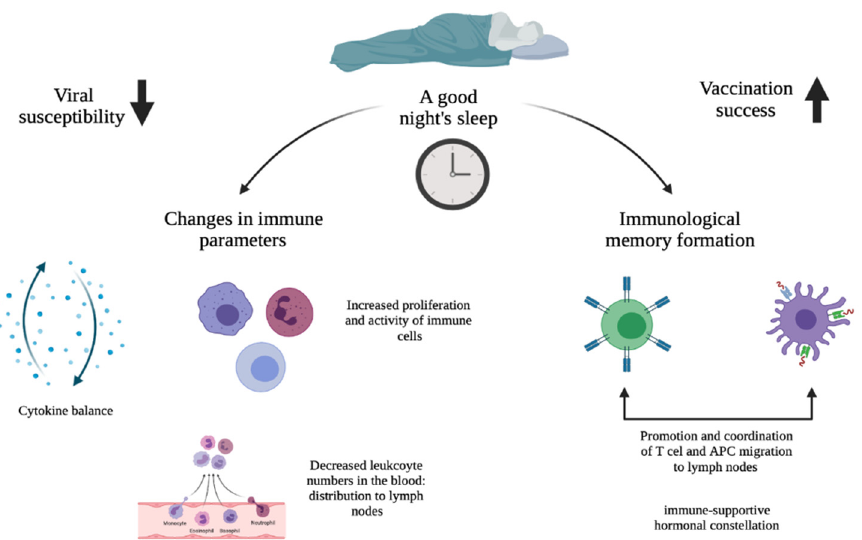
Figure 1. Schematic overview of how sleep and the circadian rhythm potentially affect viral susceptibility and vaccination success: a good night’s sleep on the one hand leads to a more optimal day–night balance in cellular immunity and cytokine production, resulting in reduced viral susceptibility (left downward arrow); on the other hand, it would lead to an improved response to vaccination through a better immunological response to the vaccine antigens (right upward arrow).